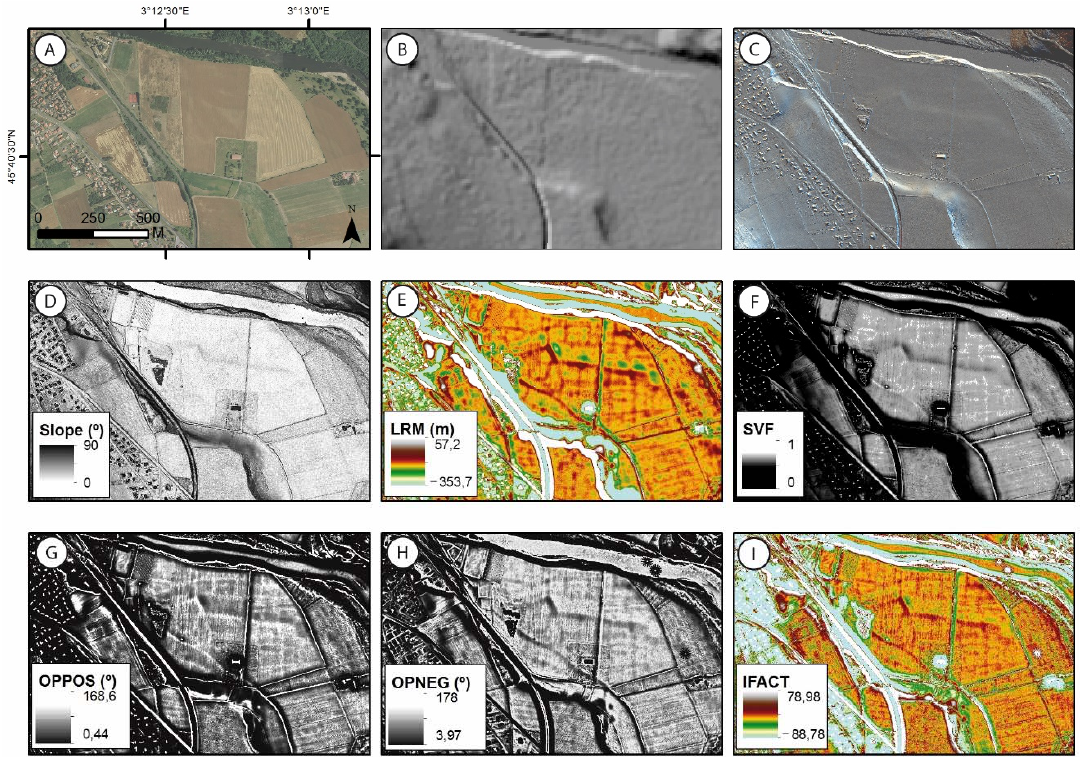
Figure 2. Examples of VTs used ( D – I ) at a 0.5 m resolution compared with other traditional techniques and DEM resolutions ( A – C ), within a flat area with ancient field patterns. The stretch type is given in parentheses. ( A ) Aerial Imagery (source: IGN, 2013); ( B ) hillshade from a 10 m photogrammetric DEM (source: CRAIG); ( C ) 0.5 m-DEM Multihillshade; ( D ) slope (Hist. Eq.); ( E ) Local Relief Model (StD); ( F )